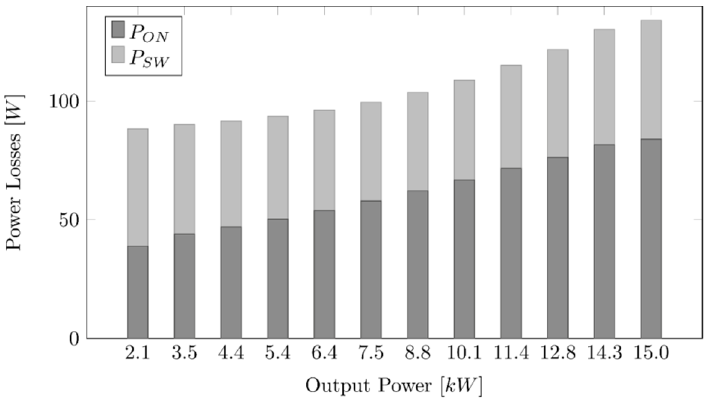
Figure 11. Analytical estimation of the separate contribution of conduction and switching losses for the total losses measured in the experimental setup.